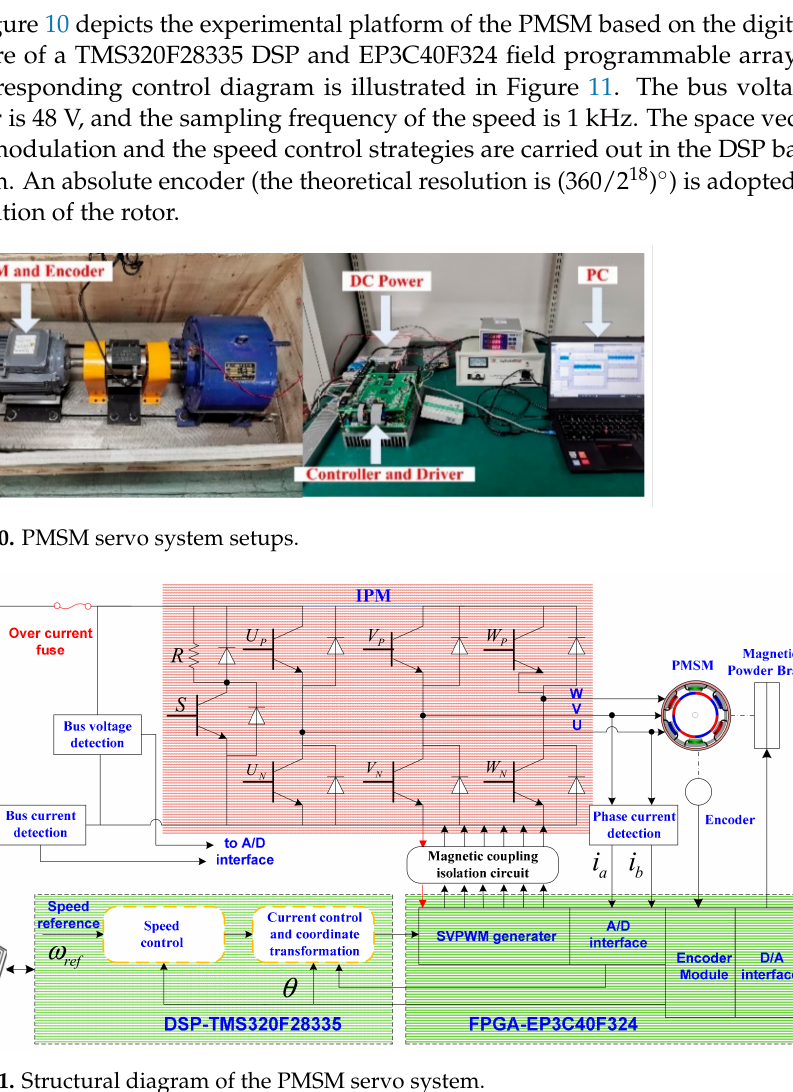
Figure 9. Estimated results using (17) and the proposed method. ( a ) The torque ripple estimating result with (17). ( b ) The torque ripple estimating result with the proposed method.